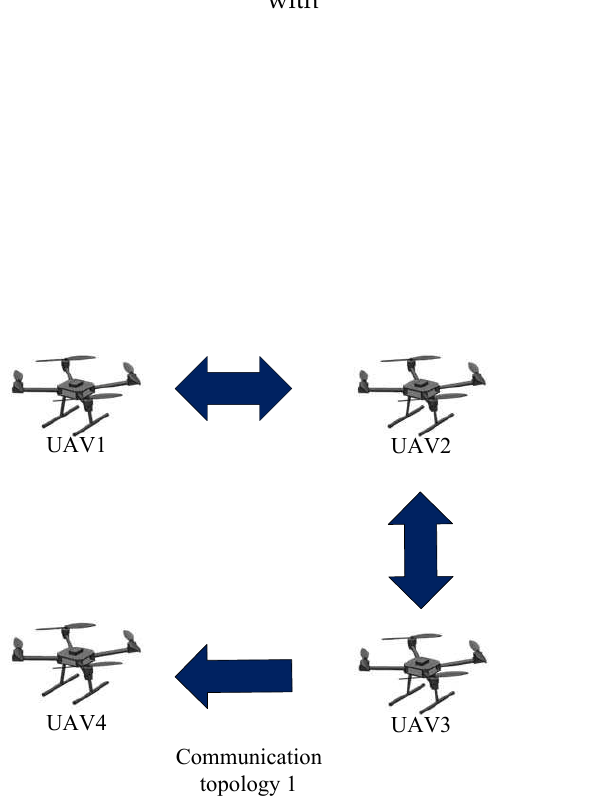
Figure 1. Illustration of switching communication topology of